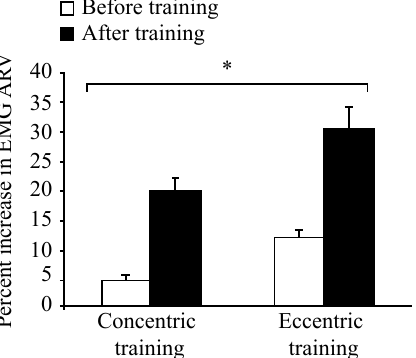
Figure 3 – Percent increase in average rectified value of EMG (percent increase from the initial 10% interval to the last 10% interval of time to task failure) for the untrained leg (average for the VM, RF and VL muscles) during sustained isometric knee extension at 50% of MVC measured before and after 12 weeks resistance training .*p ≤